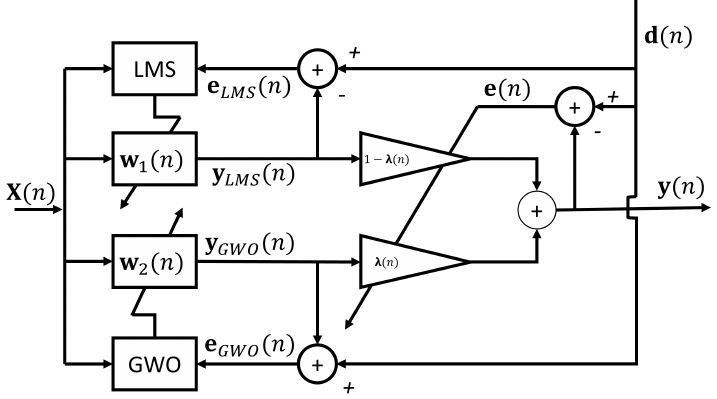
Figure 1. Proposed convex structure.